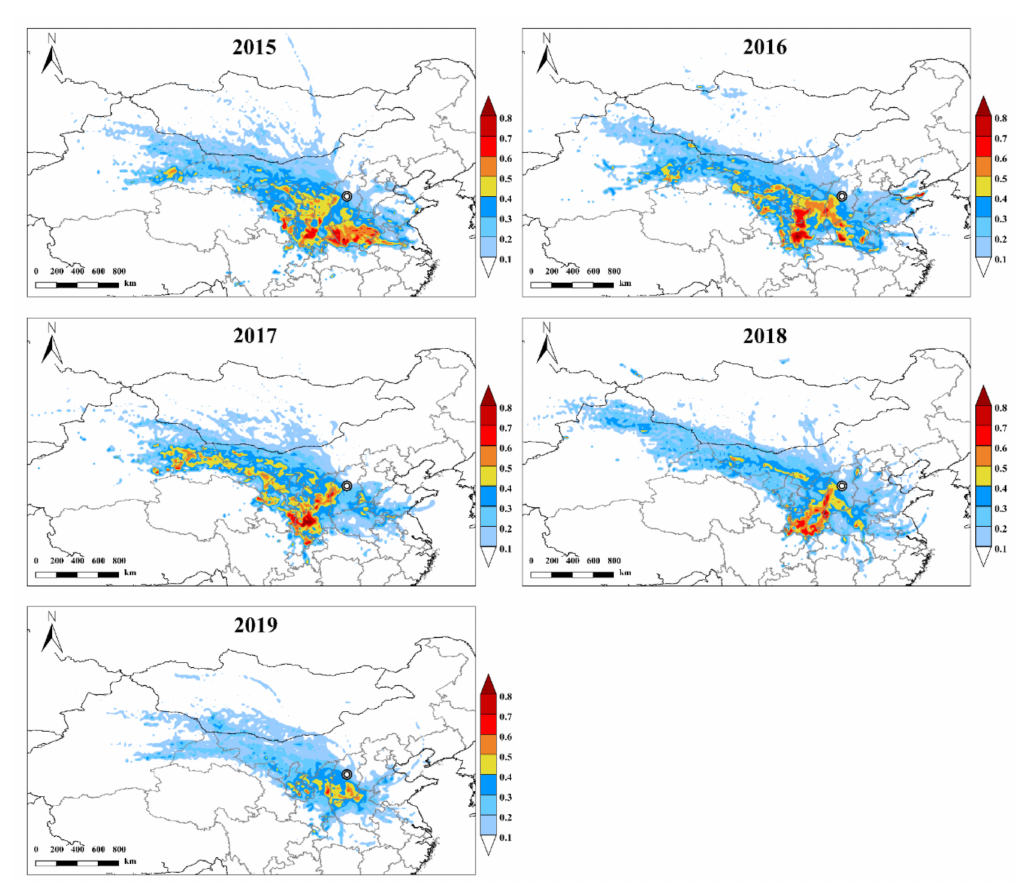
Figure 7. PSCF distribution of PM 2.5 in Taiyuan from 2015 to